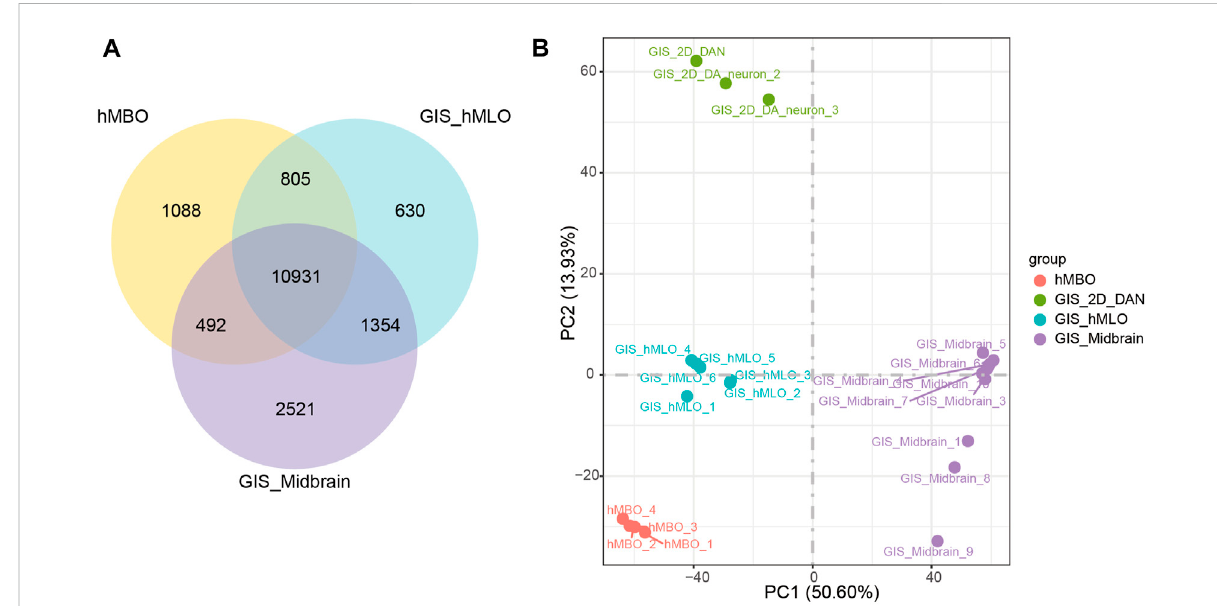
FIGURE 4 hMBOsmimickingthehumanmidbrainintranscription. (A) DGEanalysisamongthehMBO,GIS_hMLOandGIS_Midbraingroup. (B) PCAshows a clear separation between GIS_2D_DAN and the other